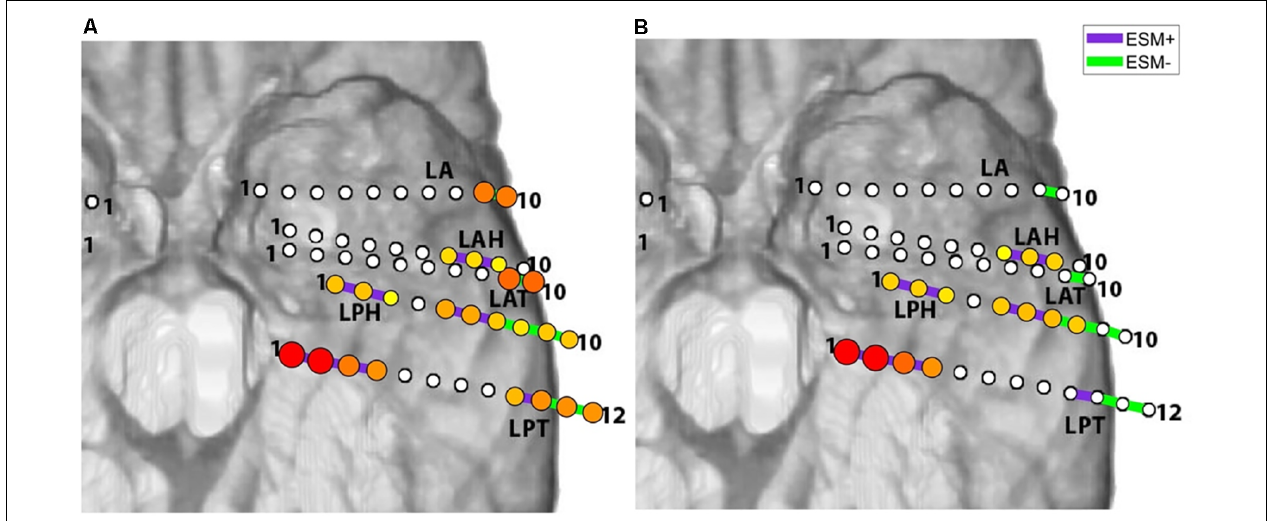
FIGURE 4 | ESM vs. its predictions by different models, for picture naming for Patient 5. Model in (A) is based on task-related STFM alone. Model in (B) uses STFM and CCEPs to estimate importance of sites to overall network dynamics and connectivity of ESM+ sites (purple bars) to other sites of importance to network dynamics. Note that ESM − sites have fewer HGM+ sites under the model on the